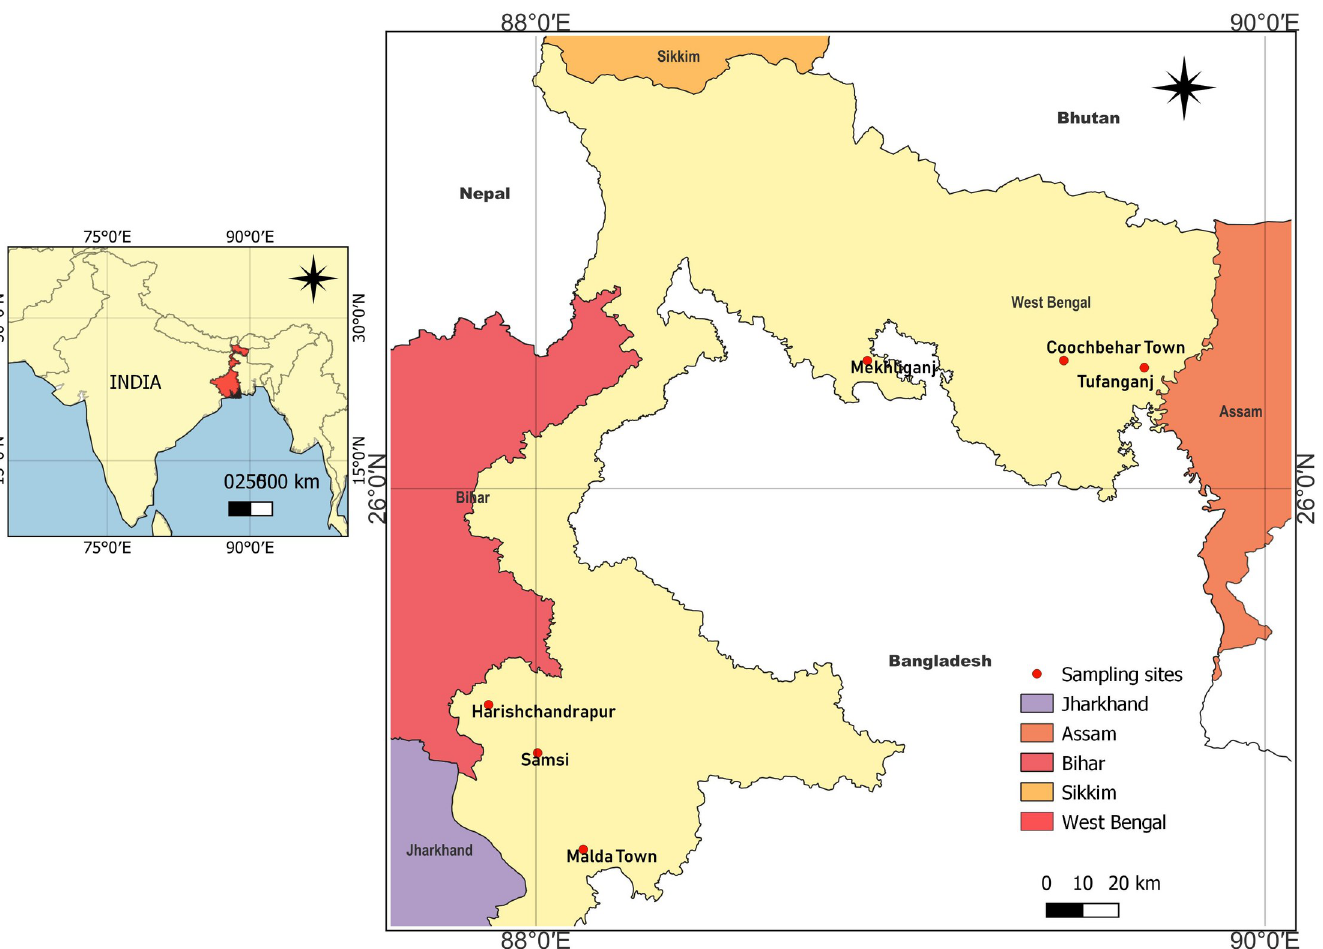
Fig 1. Map showing six sampling sites in two districts of northern part of West Bengal. (Figure created using QGIS software version 3.22. Shape file of India and West Bengal downloaded from: https://www.naturalearthdata.com/downloads/10m-cultural-vectors/).